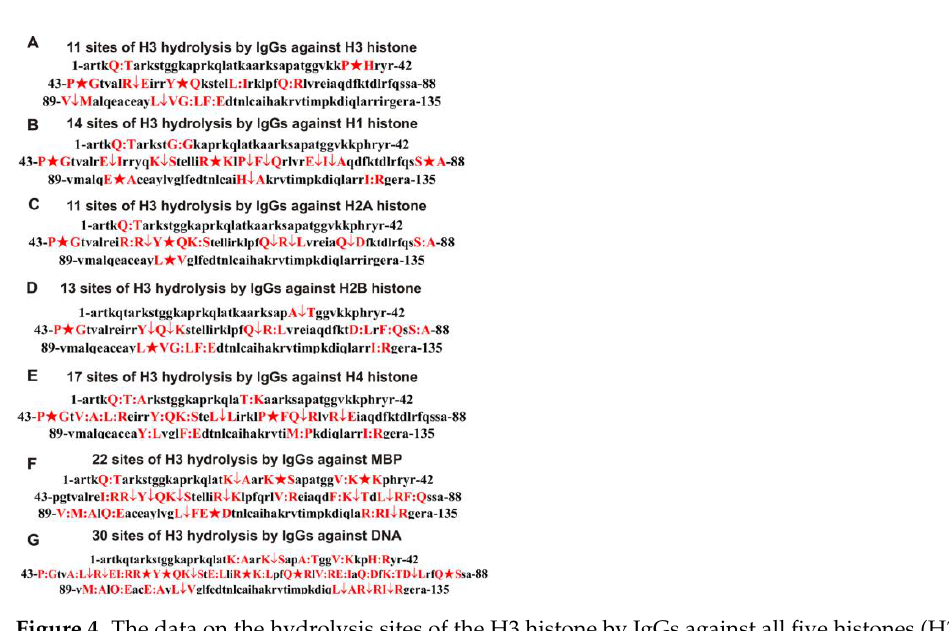
Figure 4. The data on the hydrolysis sites of the H3 histone by IgGs against all five histones (H3 ( A ), H1 ( B ), H2A( C ), H2B ( D ), and H4 ( E )), as well as against MBP ( F ) and DNA ( G ). Major cleavage sites are indicated by big stars ( ★ ), moderate sites are indicated by arrows ( ), and minor ones are splitted by colons (:) ( A – G ). Table 1. Sites of H3 histone hydrolysis by IgGs against five histones, MBP, and DNA. Type of